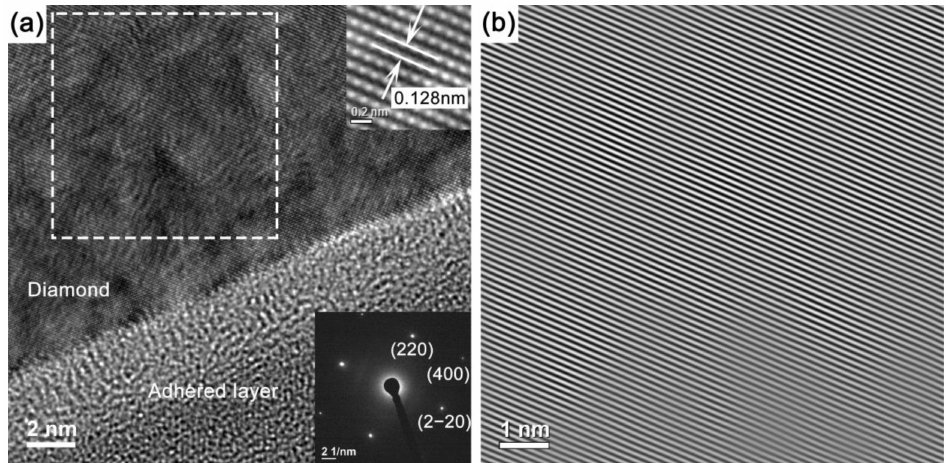
Figure 5. ( a ) High-magnification HRTEM image of surface SCD layer with selected area filtered HRTEM micrograph (top right insert), and the bottom right insert shows a typical selected area electron diffraction pattern; ( b ) inverse fast Fourier transform image of selected area marked by white-dashed box in ( a